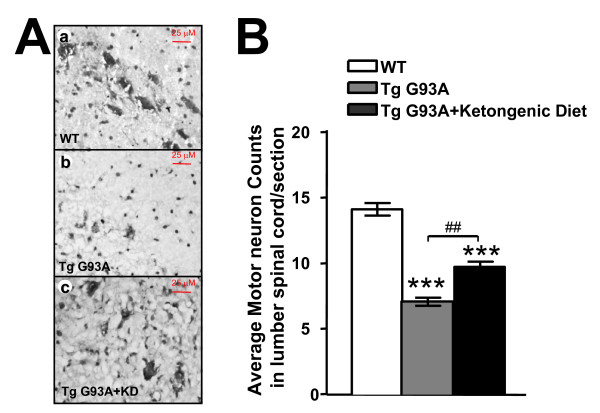
Nissl-stained motor neuron count in the lumbar spinal cord. The effect of the KD on Nissl-stained neuronal cell counts in SOD1-G93A transgenic mice at study endpoint. (A) Photomicrographs of representative Nissl-stained sections through the ventral horns of the lumbar spinal cord from wild-type (WT) (a), standard diet- (b) and KD (c) treated SOD1-G93A mice. Horizontal bar = 25 μm. (B) The counts of the large motor neurons in lumbar spinal cord of WT control and of SOD1-G93A treated with standard diet or KD (data = mean ± se; WT: n = 5, Tg G93A: n = 4, Tg G93A+KD n = 6; ## - p = 0.003, Tg G93A vs. Tg G93A+KD; *** - p < 0.001 vs. WT).